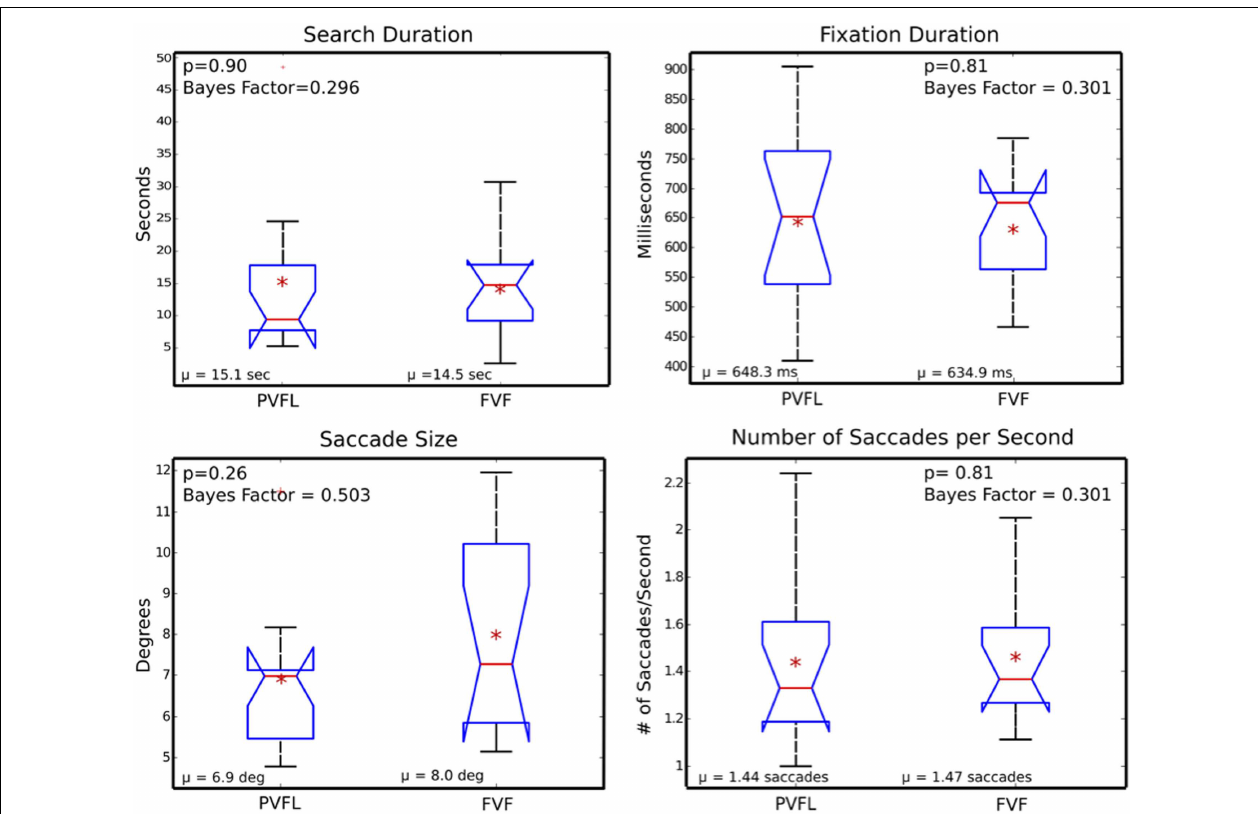
mean of each distribution and a red cross marks outliers. Comparison intervals are shown with notches.Whiskers display the minima and maxima of the distributions (excluding outliers). None of the parameters were significantly different between PVFL and FVF groups ( p values and Bayes Factors shown inset). Bayes factors are listed in the form